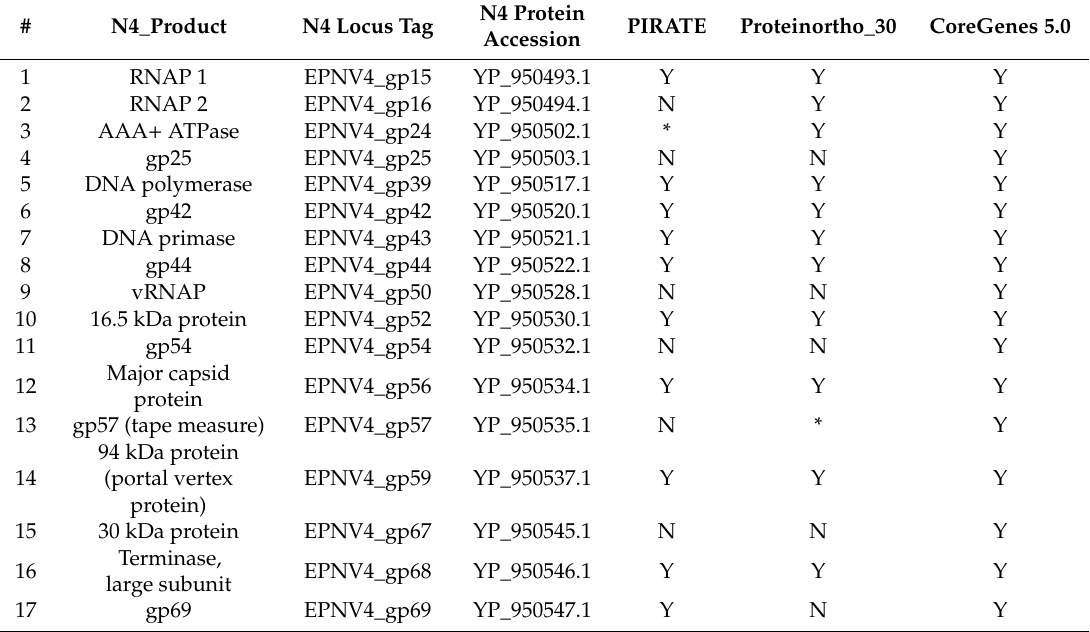
Table 2. Panproteome analysis of N4-like viruses using three di ff erent